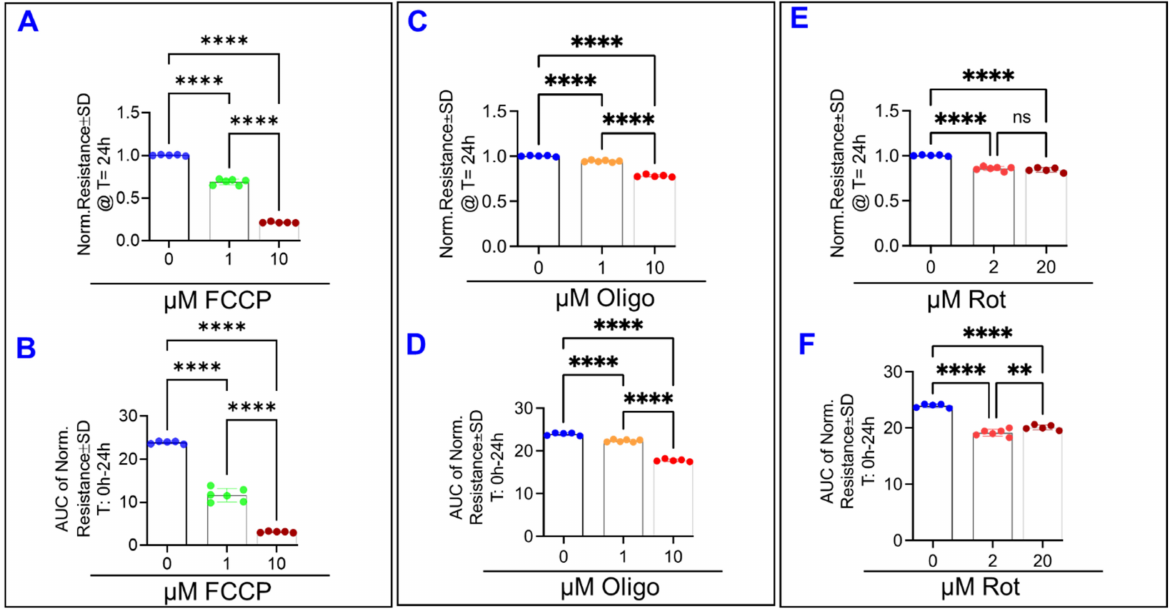
Figure 12. Effects of mitochondrial inhibitors on ARPE-19 cells total resistance at experimental midpoint T = 24 h. ( A ) Mid- point resistance at T = 24 h for the ARPE-19 cells treated with FCCP. After 24 h of treatment with FCCP, there is a dose-dependent effect of FCCP on the midpoint resistance. ( B ) Area under the curve (AUC) of total resistance for the